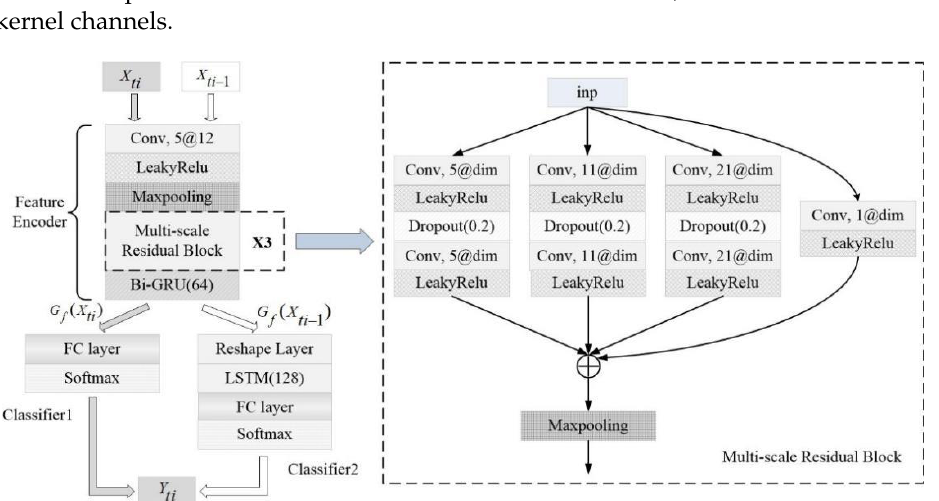
Figure 2. The architecture of the pre-training model. X ti and X ti − 1 represent the current ECG sequence and the previous 30 s ECG sequence, respectively. Y ti is the prediction of the current 30 s sleep stage. “X3” means 3 multi-scale residual blocks. The block is described in the dashed box, where “5@dim” in the convolution layer indicates kernel size 5 and “dim” kernels where “dim” is different for different blocks.